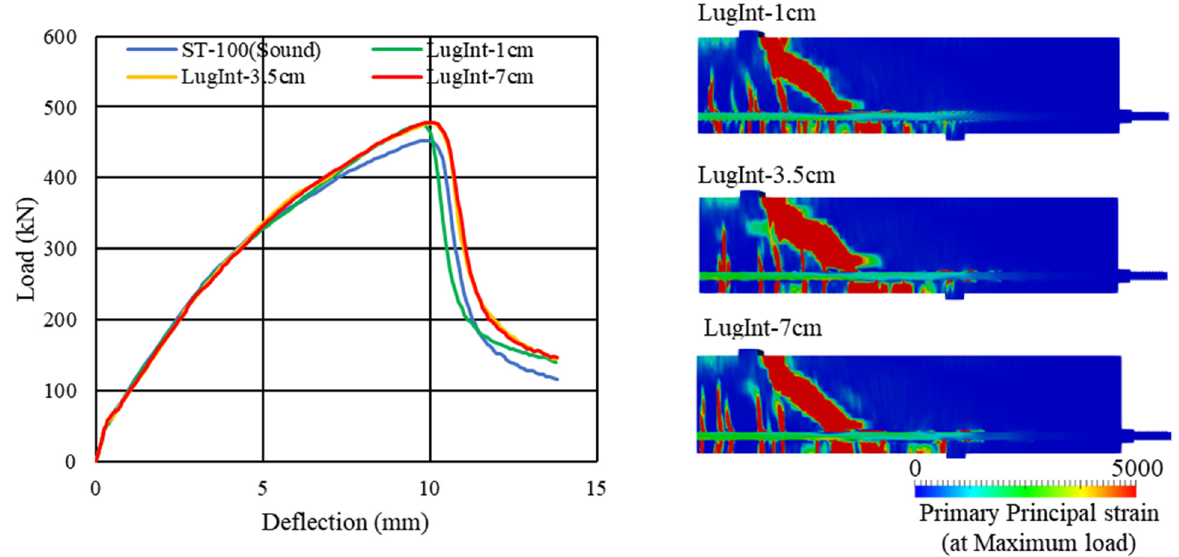
Figure 16. Analysis results (effect of non-uniform lug loss in axial direction of rebar).